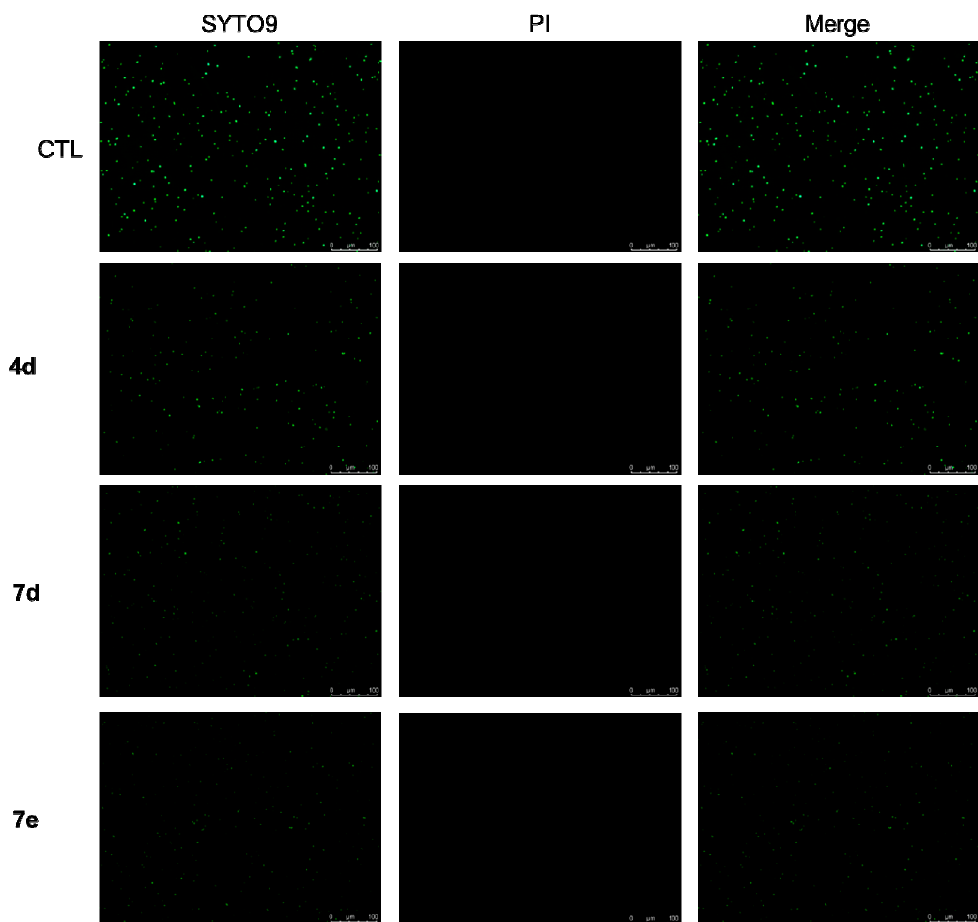
Figure 4. The live / dead imaging by treatment with 10 µ g / mL of di ff erent compounds against planktonic Figure 4. The live/dead imaging by treatment with 10 μ g/mL of different compounds against MRSA. Scale bar: 100 µ planktonic MRSA. Scale bar: 100 μ m